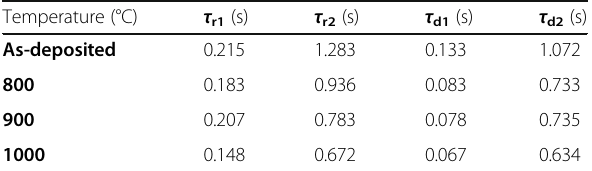
Table 3 The rise time and decay time of UV photodetectors without post annealing and after the annealing at different temperatures